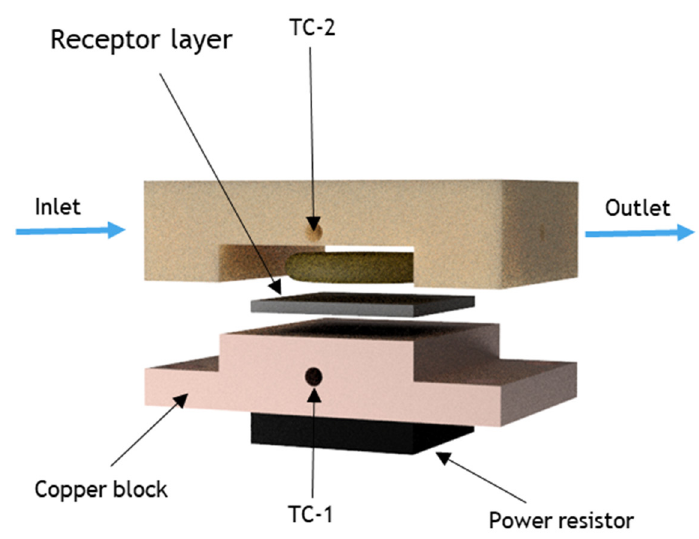
Figure 1. Graphical representation of the HTM analysis setup.